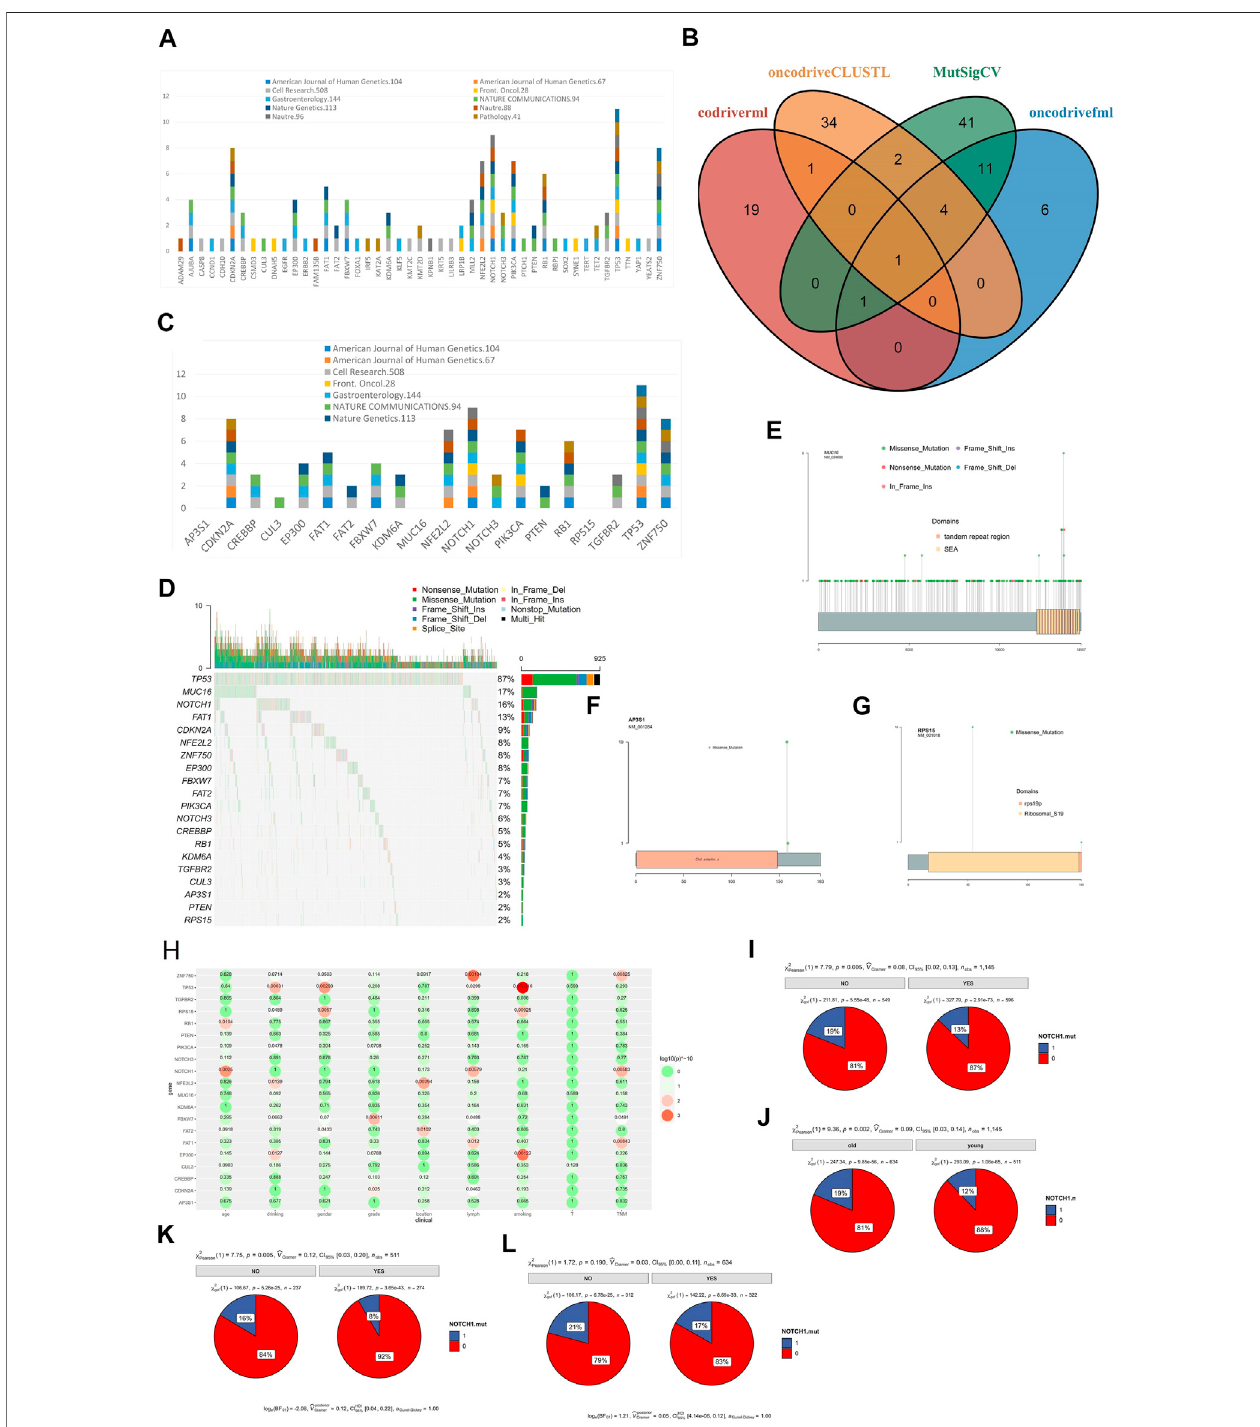
FIGURE5| SMGsinESCC. (A) SMGsofESCCinpreviousstudies, (B) SMGsofESCCidenti fi edby4software, (C) ThedistributionofSMGsofESCCidenti fi edby 4softwareinpreviousstudies, (D) Mutationpro fi leofSMGsinESCC, (E) MUC16 mutationinESCC, (F) AP3S1 mutationinESCC, (G) RPS15 mutationinESCC, (H) The correlation between SMGs ofESCC and clinical characteristics, (I) The correlationbetween NOTCH1 mutation and lymph node metastasis of ESCC, (J) The correlation betweenNOTCH1mutationanddifferentagegroupofESCCpatients(youngandold), (K) ThecorrelationbetweenNOTCH1mutationandlymphnodemetastasis of young ESCC patients (age < 60), (L) The correlation between NOTCH1 and lymph node metastasis of old ESCC patients (age > (cid:1) 60).